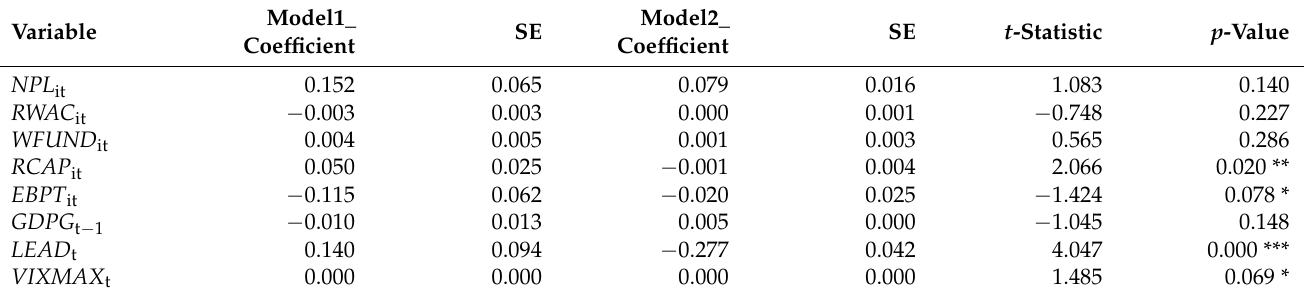
Table A9. Comparison of crisis (adjusted) (4) and post-crisis (adjusted)